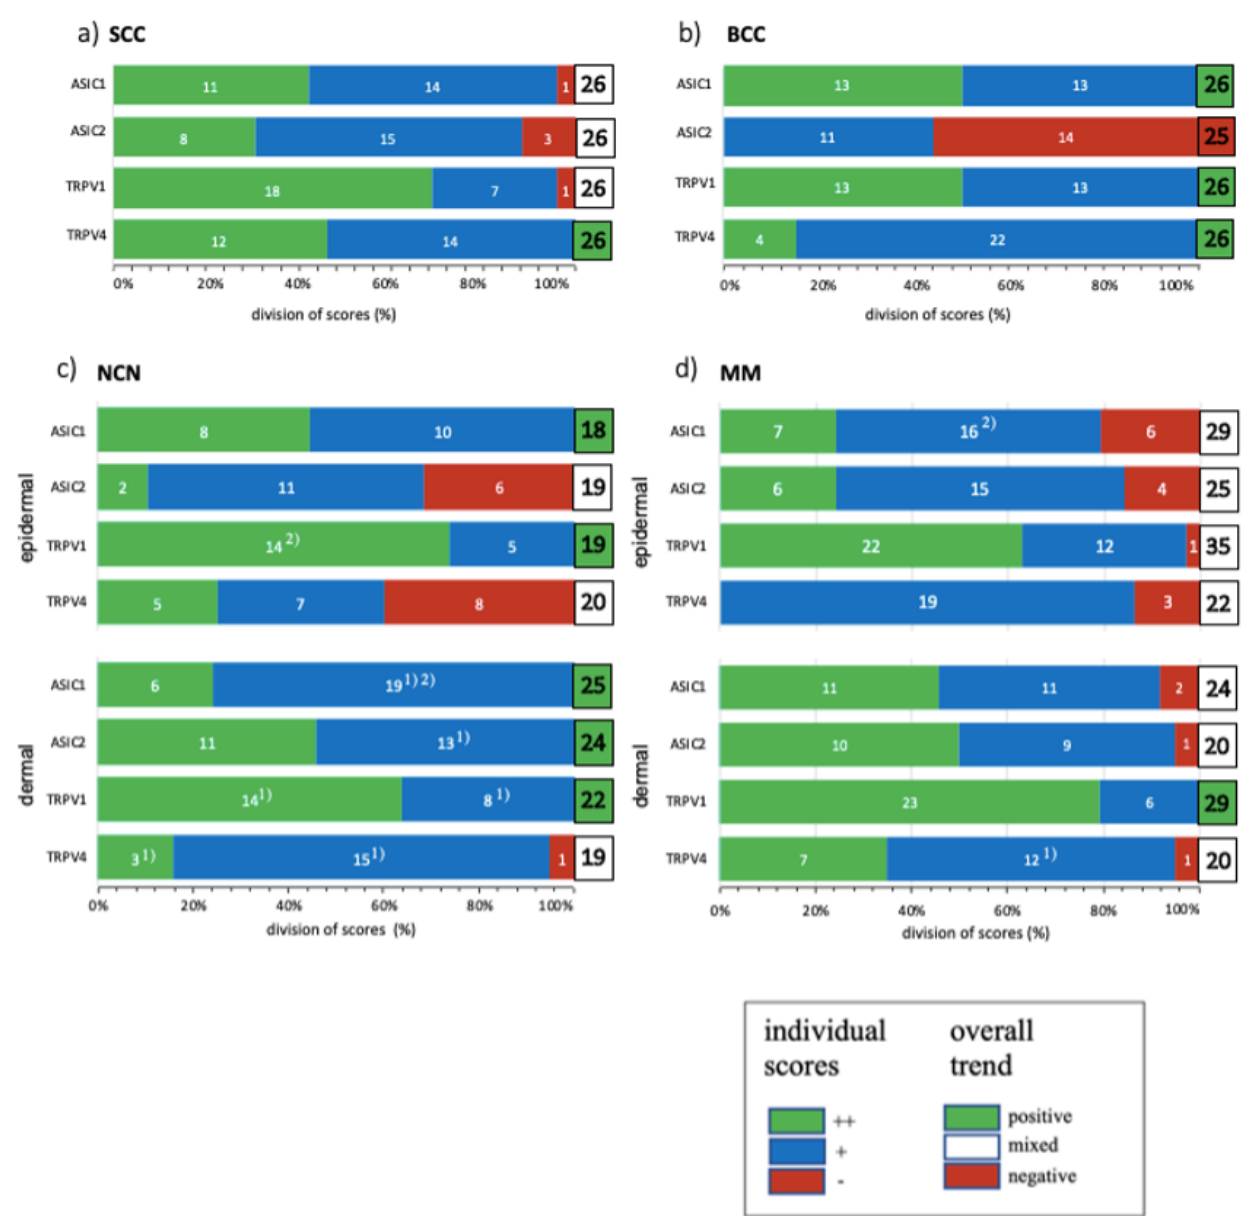
Figure 5. Summary of standard immunohistochemical and TMA score results for ASIC1, ASIC2, TRPV1 and TRPV4 on ( a ) SCC, ( b ) BCC, ( c ) NCN and ( d ) MM. ++/green bar: strong positive staining with >80% of cells positive and/or staining intensity is high; +/blue bar: 20–80% of cells show a weak positive/partial positive reaction; − /red bar: <20% of cells with weak staining (=negative reaction). NCN and MM are subdivided into epidermal and dermal portions. Numbers in bars represent the occurrence of the particular score. Superscript numbers give additional information: (1) some samples showed a decreasing expression in deeper dermal tumor tissue. (2) Single tumor cells are stained strong positive, others appear negative, resulting in an overall partial positive score (+). Overall trend is indicated by a green, white or red box with the number of samples investigated; green box: general positive reactions; white box: mixed reactions; red box: mainly negative reactions. For additional information on the individual TMA scores, see Supplementary Tables